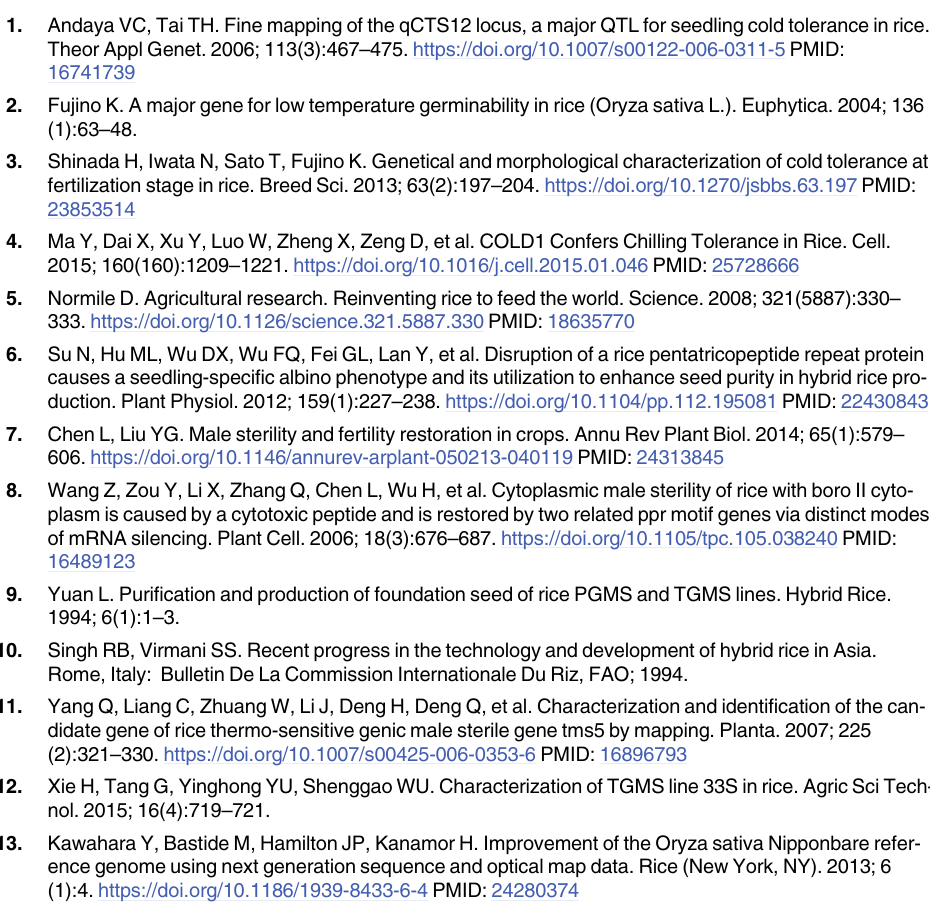
S11 Table. TF response to low-temperature treatment of 33S. S12 Table. TF response to low-temperature treatment of